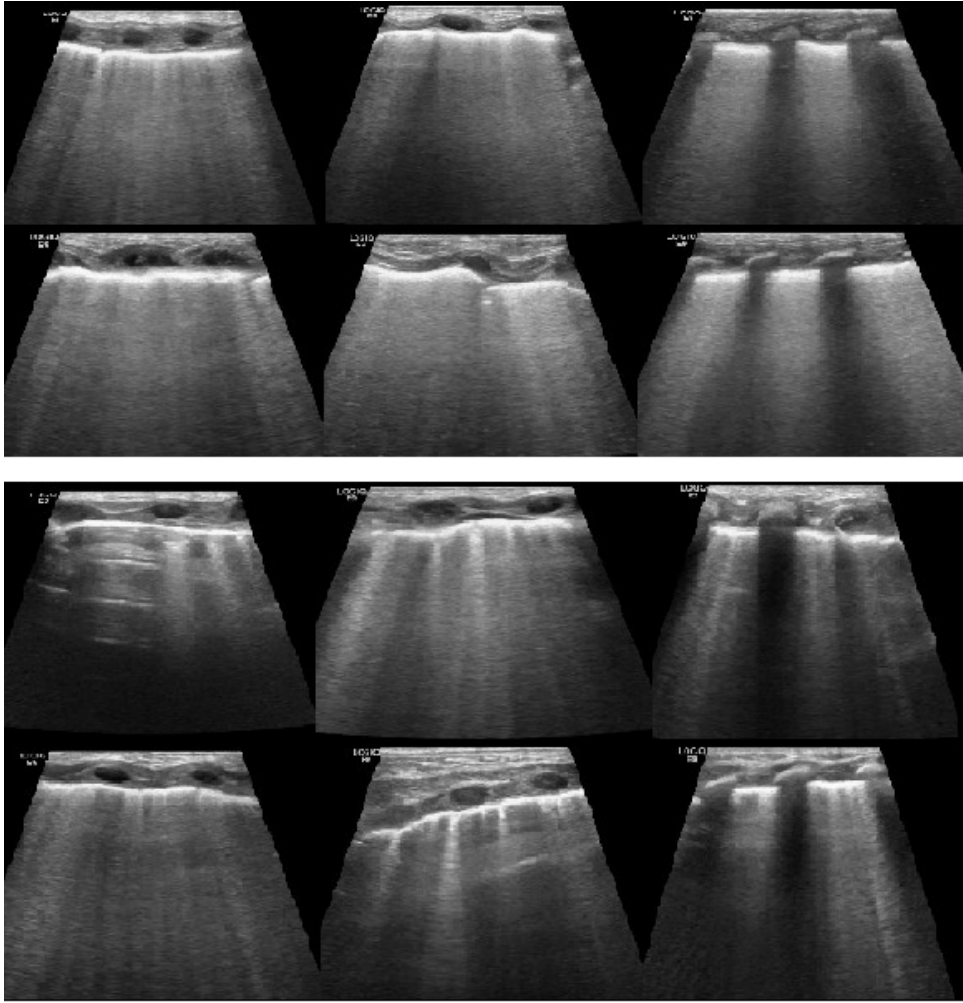
Figure 1. Sonograms at T0 and at T1 of a patient diagnosed with RD. After the positioning of the nCPAP the nlus score has lowered accordingly with the reduction of the coalescent b lines areas. In the second sonogram, the appearance of A lines can easily be noticed.